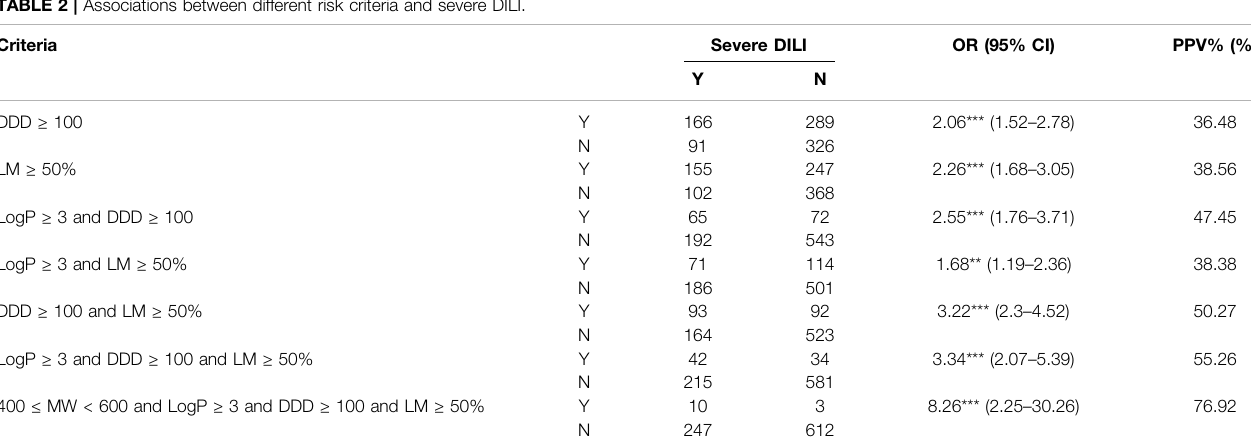
TABLE 2 | Associations between different risk criteria and severe DILI.